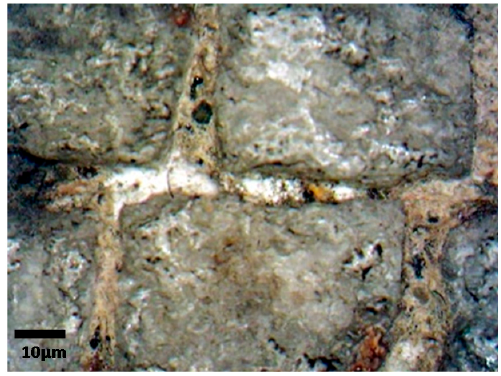
Figure 24. Thermal image of the mosaic surface in the investigated galleries.